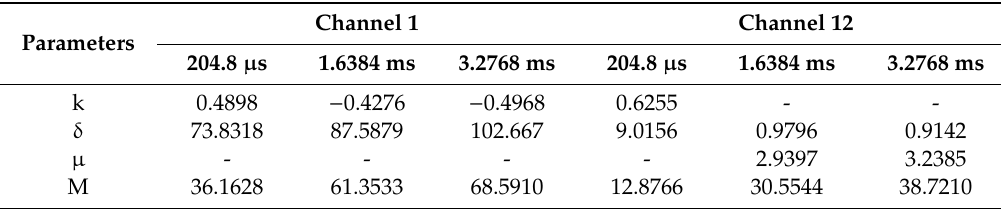
Table 5. Parameters for best fitted